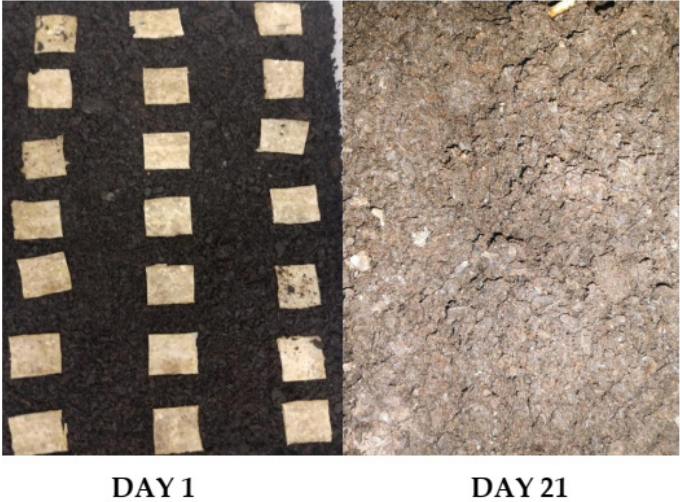
Figure 1. Samples of foam developed from the potato by-products on the first and twenty-first days of the biodegradability analysis.